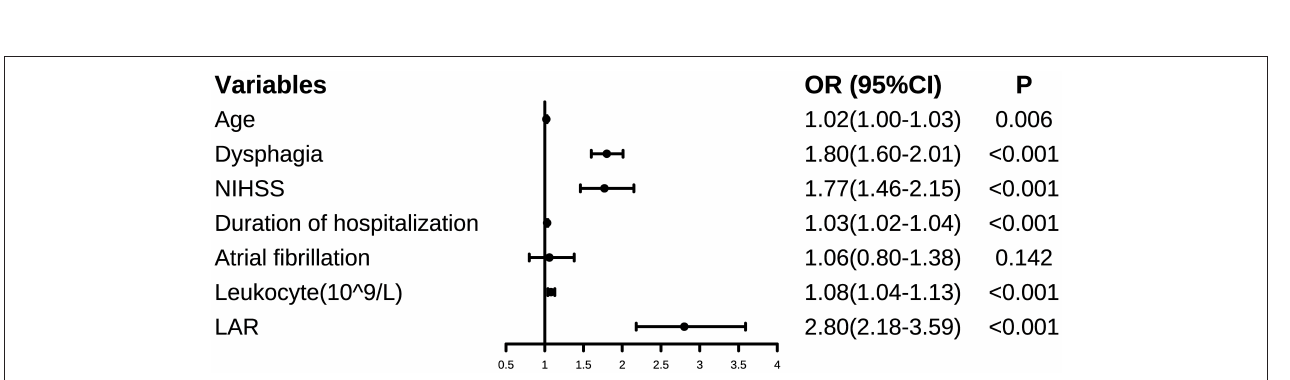
Frontiers in Nutrition |